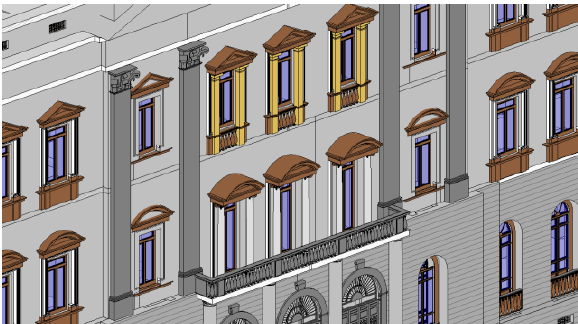
Figure 7. Naples Front of the Federico II building on corso Umberto I. 3D model (2018)